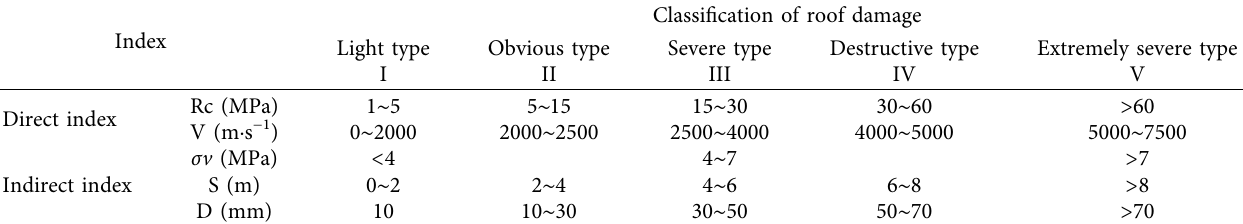
Table 5: The range of the value of each index to determine the degree of roof damage.